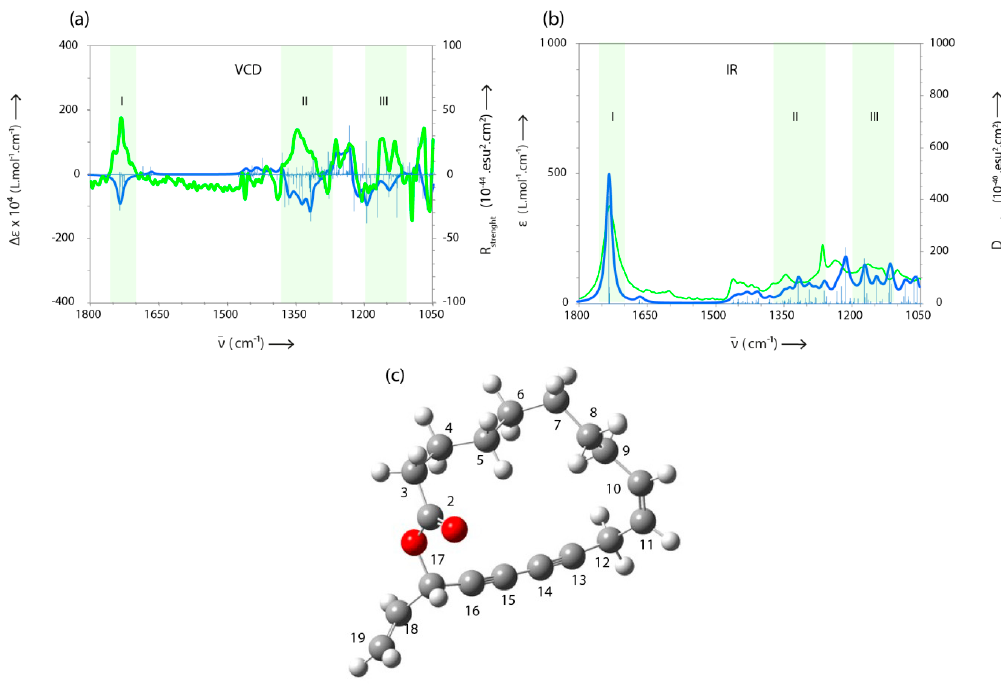
Figure 5. A comparison between the measured (blue) and calculated (green) ( a ) VCD and ( b ) IR spectra, respectively; ( c ) one of the most stable simulated structures of Campestrolide (generated for ( Z , S )-enantiomer). N.B. Atoms colors: oxygen in red; carbon in gray; hydrogen in white.